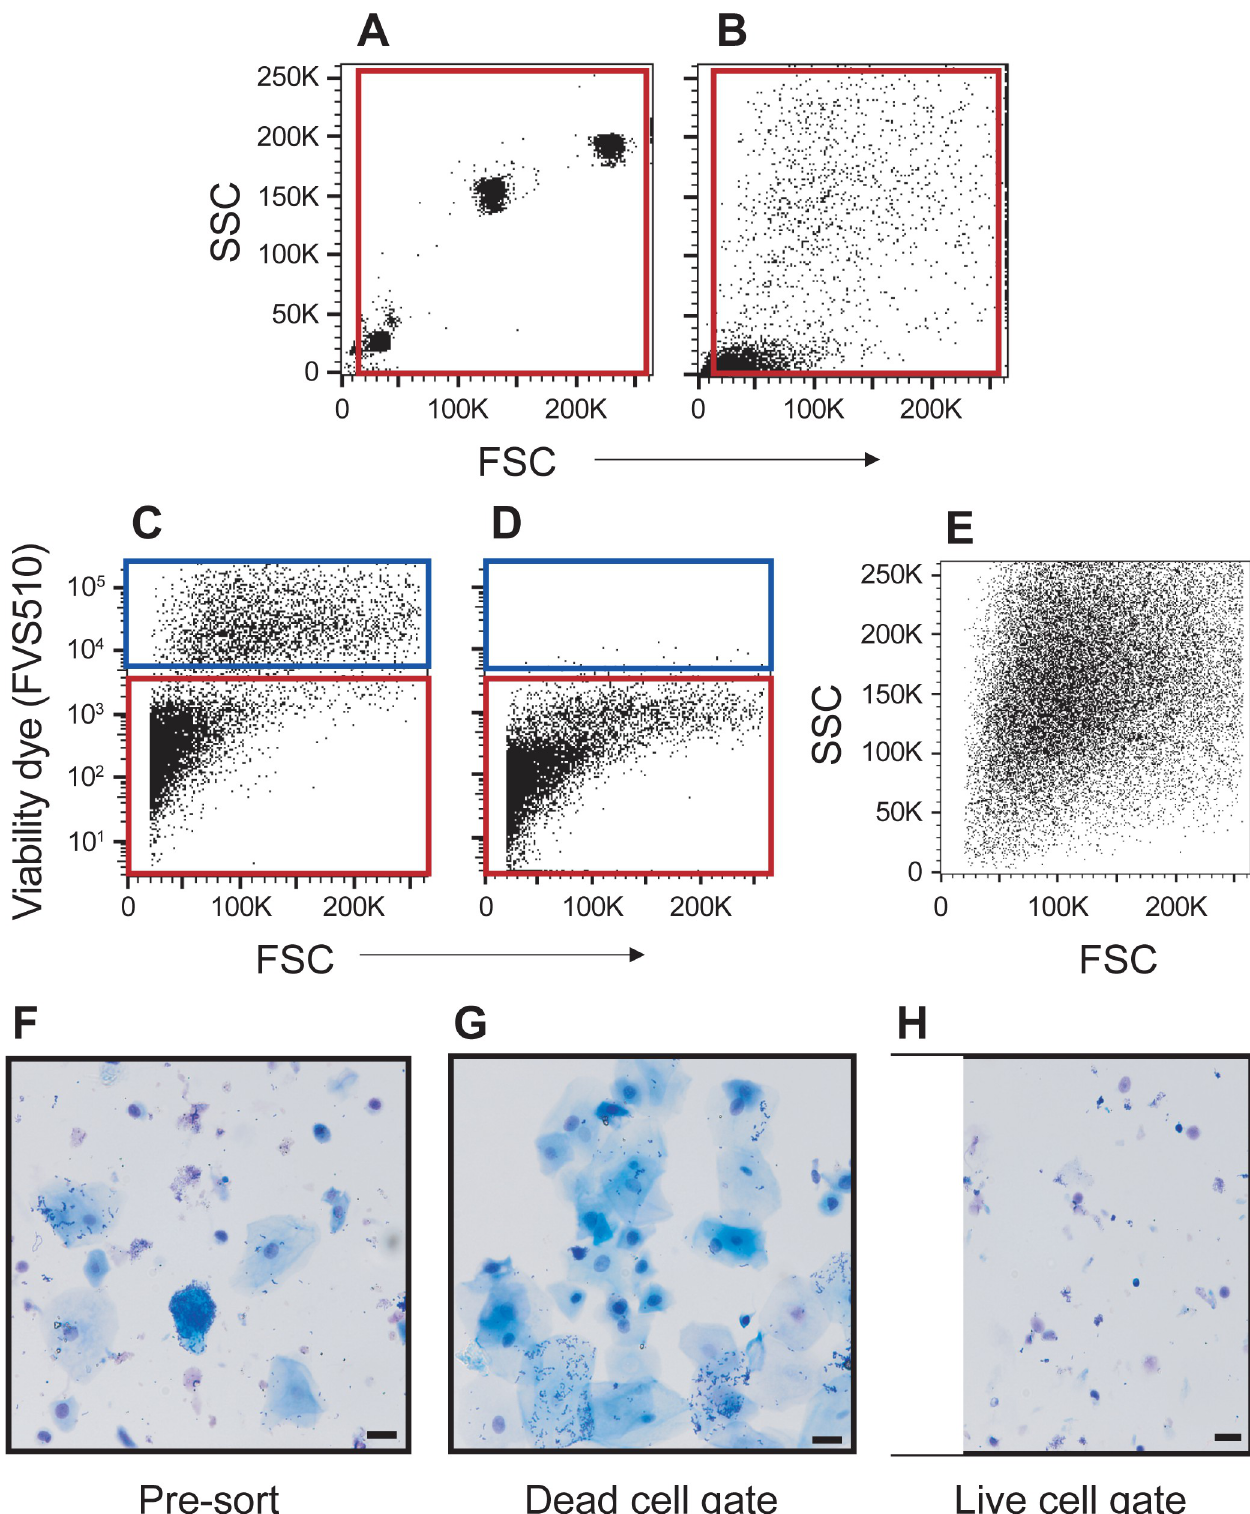
Fig 2. Viability dye labels squamous epithelial cells as dead cells. Light scatter profiles of 5 μ m, 20 μ m, and 30 μ m particles (A) and dissociated sputum cells ( B ), both using the same voltage settings. The red boxes in A and B indicate a gate to exclude small debris (the bottom, left corner) as well as cell aggregates